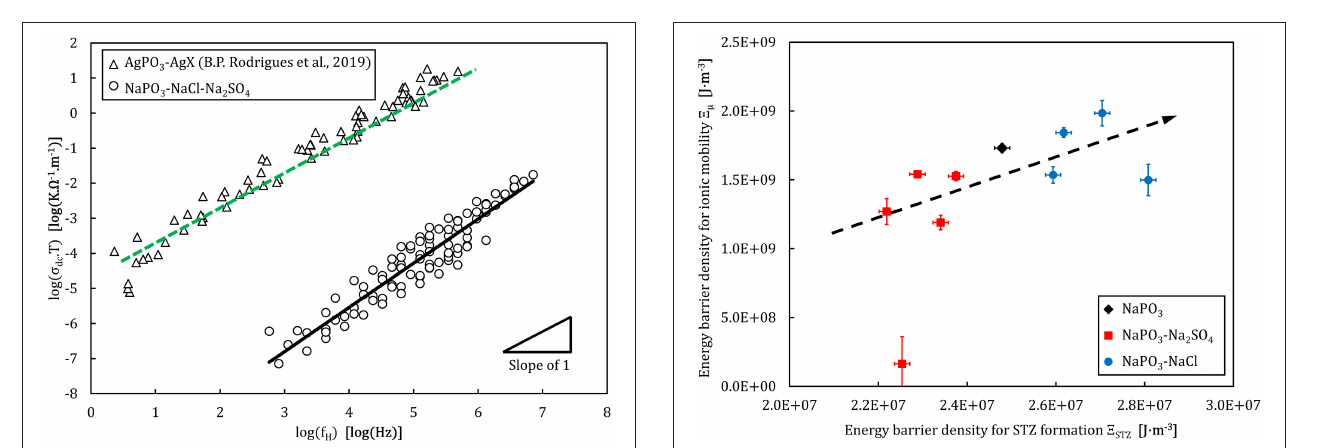
FIGURE 11 | Ionic mobility energy barrier density and the STZ formation energy barrier density derived from experimental data for the NaPO 3 -NaCl-Na 2 SO 4 glass system. The dashed line is a guide to the eye.